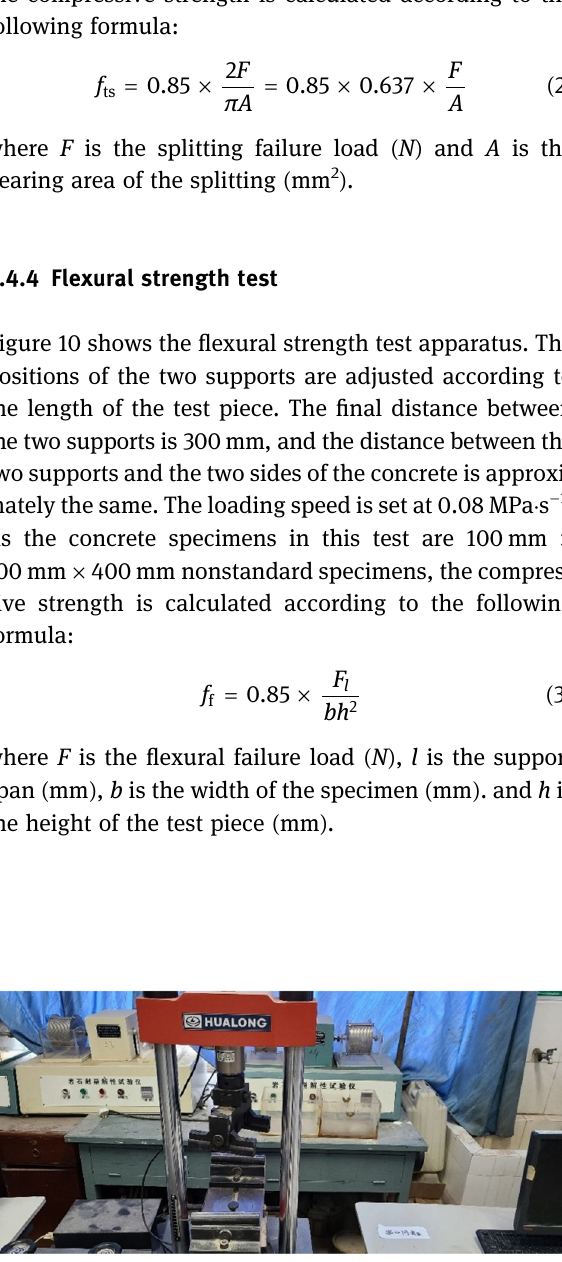
Figure 9: Tensile strength test apparatus. Figure 10: Flexural strength test